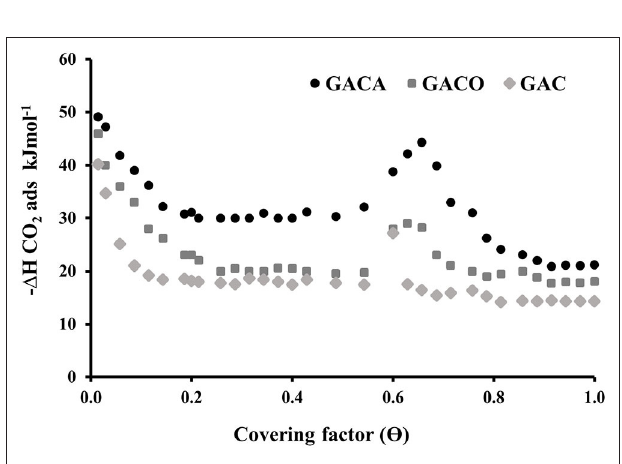
FIGURE 6 | Differential heat of adsorption of CO 2 for the prepared samples.